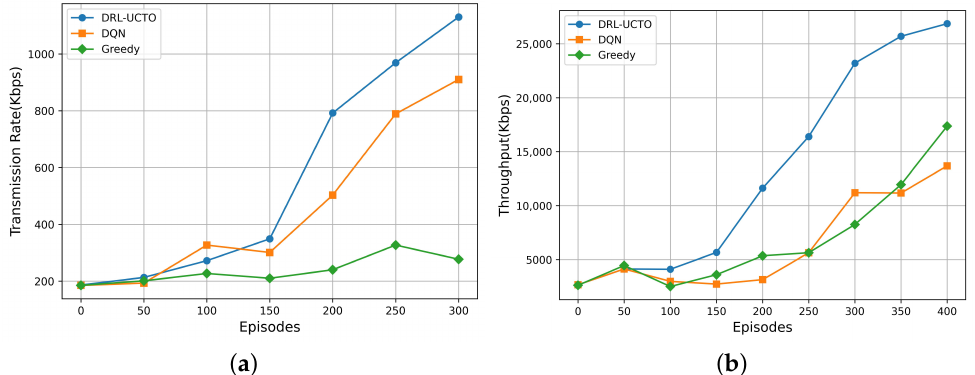
Figure 4. The performance of different algorithms in terms of transmission rate and through- put. ( a ) Transmission rate of UAVs versus training episodes. ( b ) System throughput versus train- ing